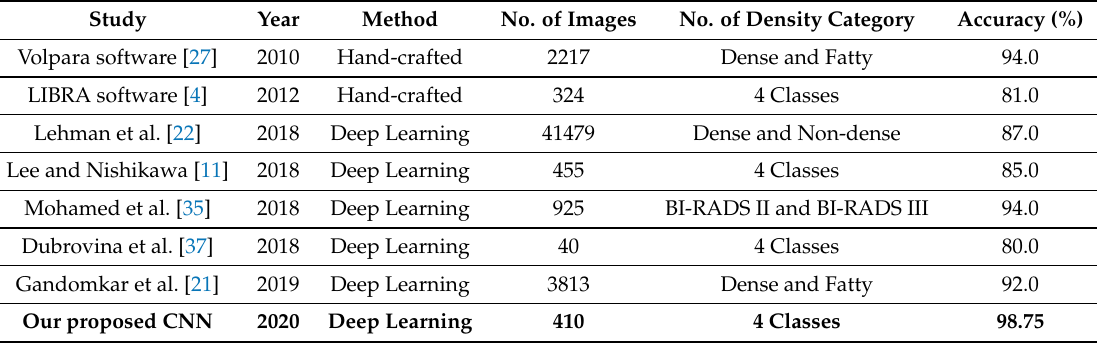
Table 8. Accuracy of different breast density classification in terms of their best